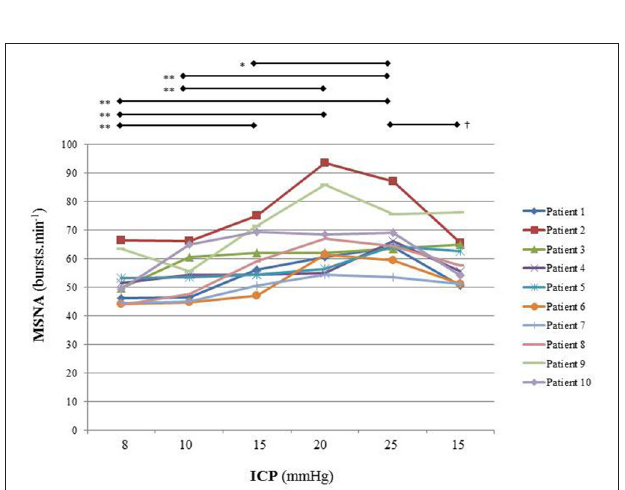
FIGURE 6 | Individual sympathetic activity in each patient during modest ICP increase and decrease ( n = 10). Statistical analysis was performed using ANOVA for repeated measures with Tukey’s post-test. * p < 0.05, ** p < 0.01 vs. baseline and † p < 0.05 vs. plateau.